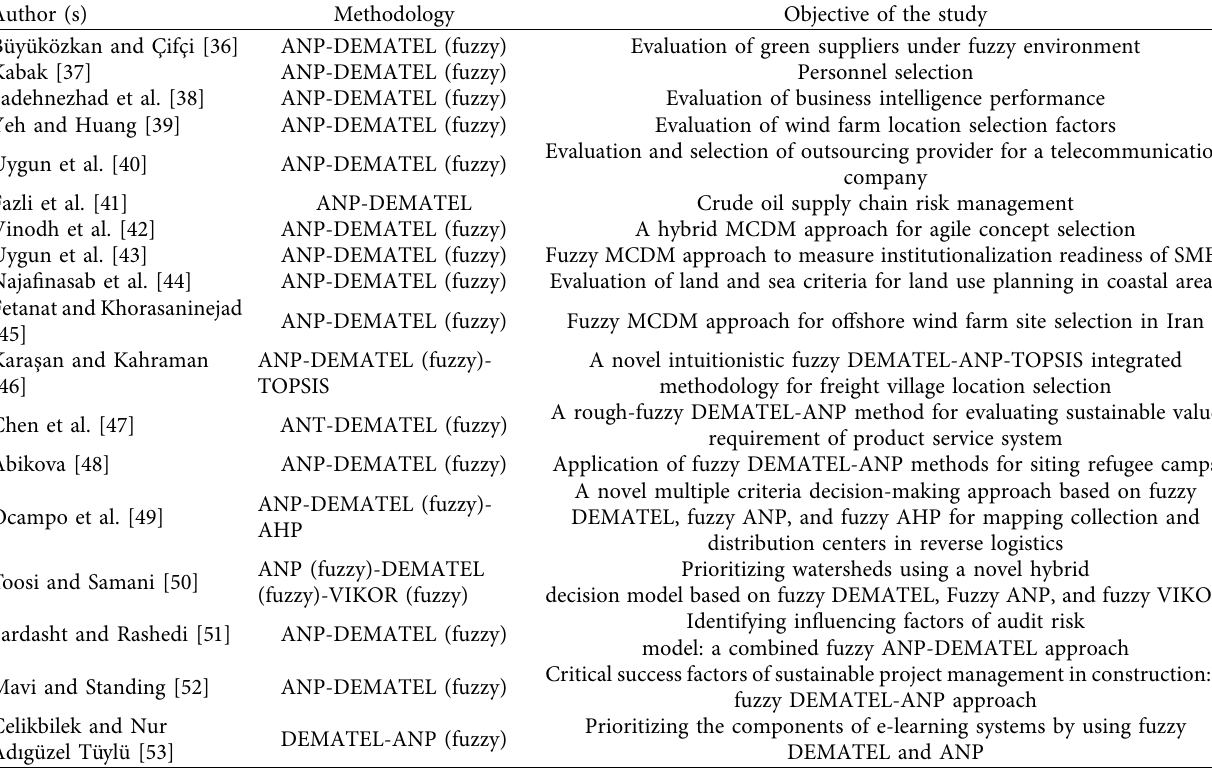
Table 1: Application of fuzzy DEMATEL and